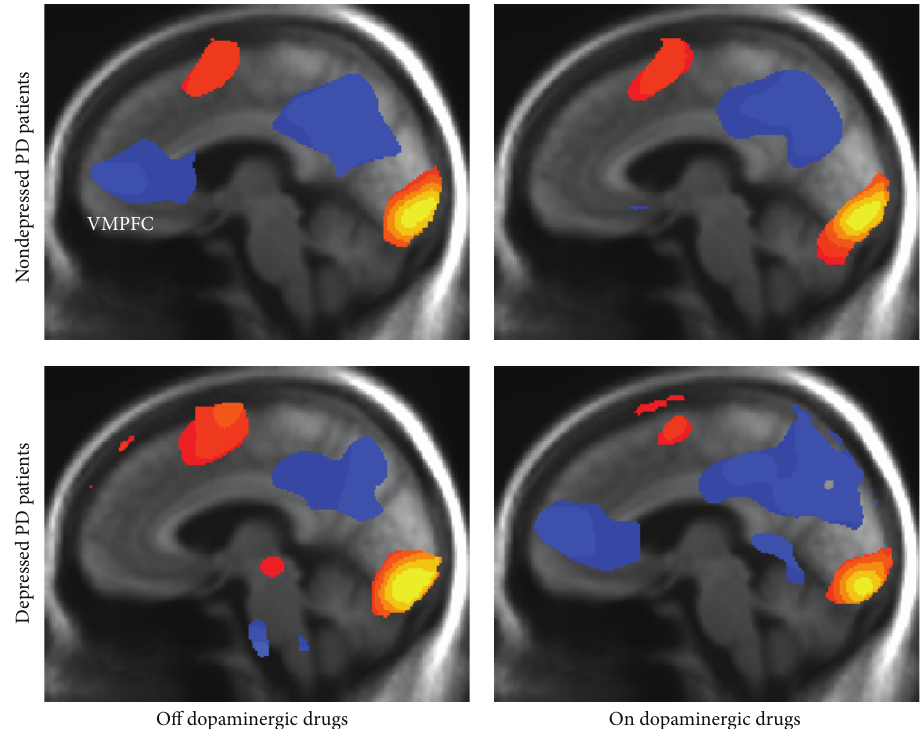
Figure 1: Maps thresholded at the same level of statistical significance ( 𝑃 < 0.001 ) showing medication-related variations in the response patterns among depressed and nondepressed PD